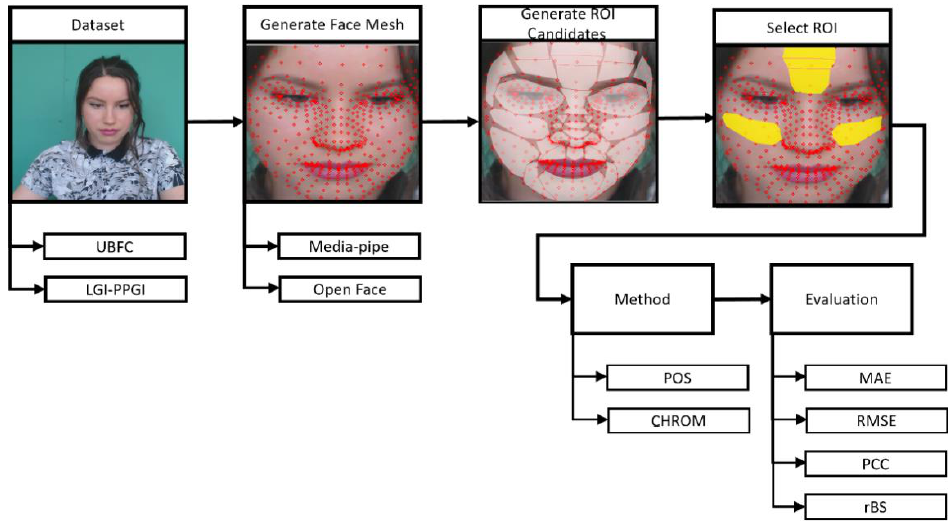
Figure 3. ROI assessment procedure.